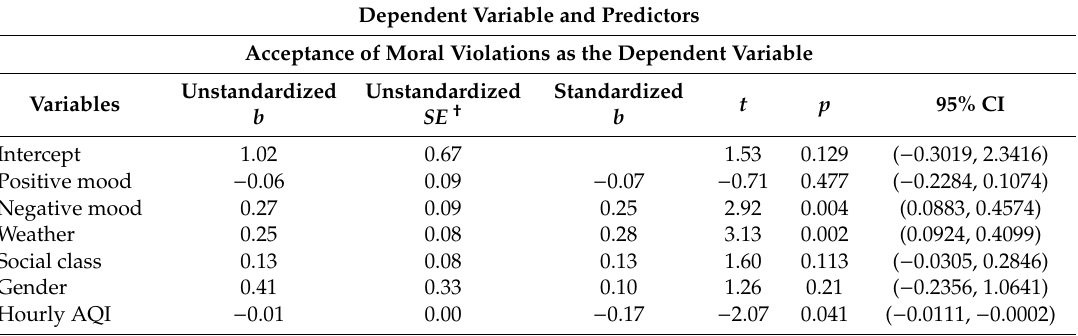
Table 2. The full regression results of Study